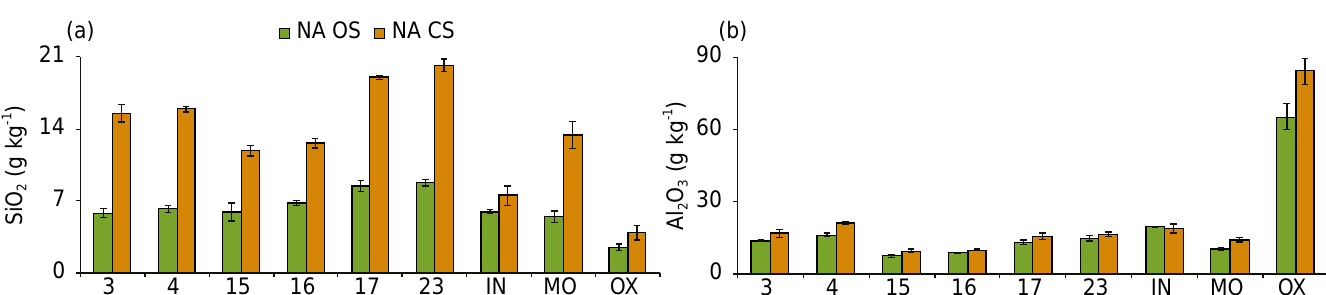
Figure 4. Contents of SiO 2 and Al 2 O 3 of the clay fraction extracted by nitric acid in an open system (NA OS) and nitric acid in a closed system (NA CS). IN: Inceptisol; OX: Oxisol; MO: